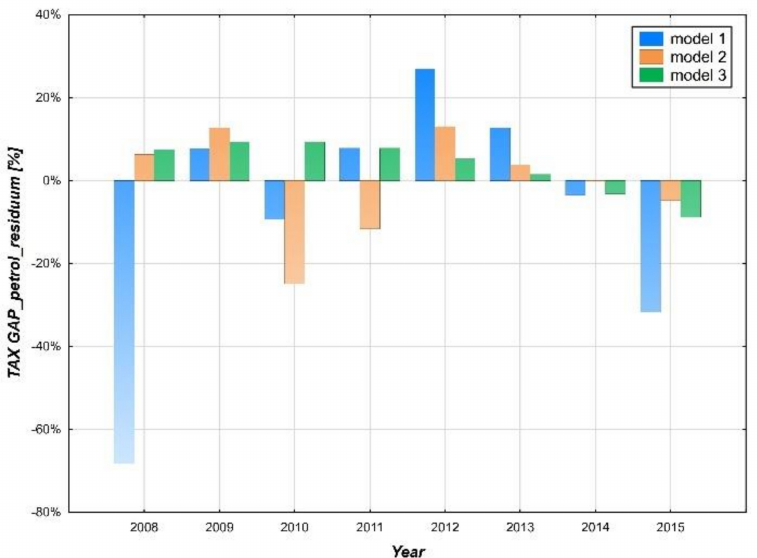
Figure 11. Residues of the prediction models TAX GAP_petrol (%) in the years